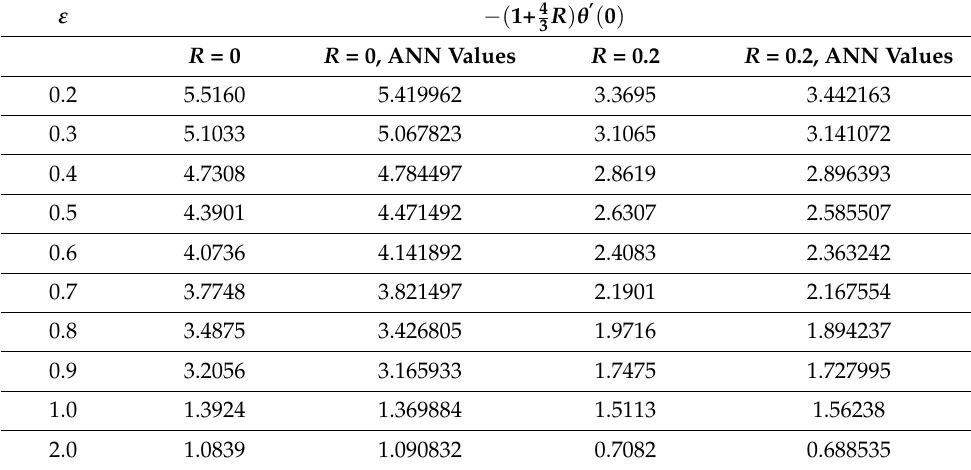
Table 7. Impact of variable thermal conductivity on Nusselt number for non-radiative and radiative flow fields.